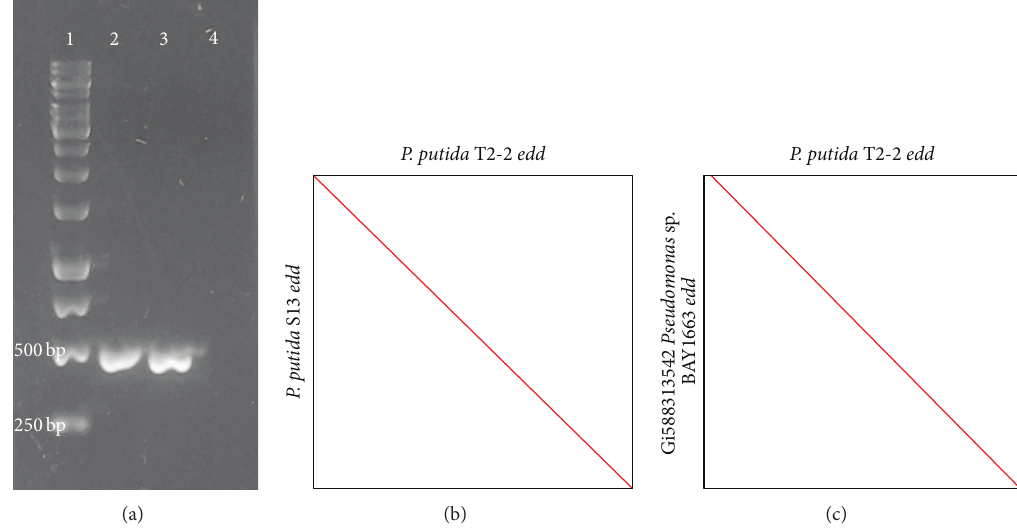
Figure 2: (a) Agarose gel image for 1: 1kb DNA ladder; 2: PCR product edd gene in P. putida T2-2; 3: PCR product edd gene in P. putida S13 which serves as positive control, and 4: negative control . (b) Dot plot from DNA sequence of edd gene of P. putida T2-2 against P. putida S13. (c) Dot plot from amino acid sequence of edd gene of P. putida T2-2 against reference gene Pseudomonas strain